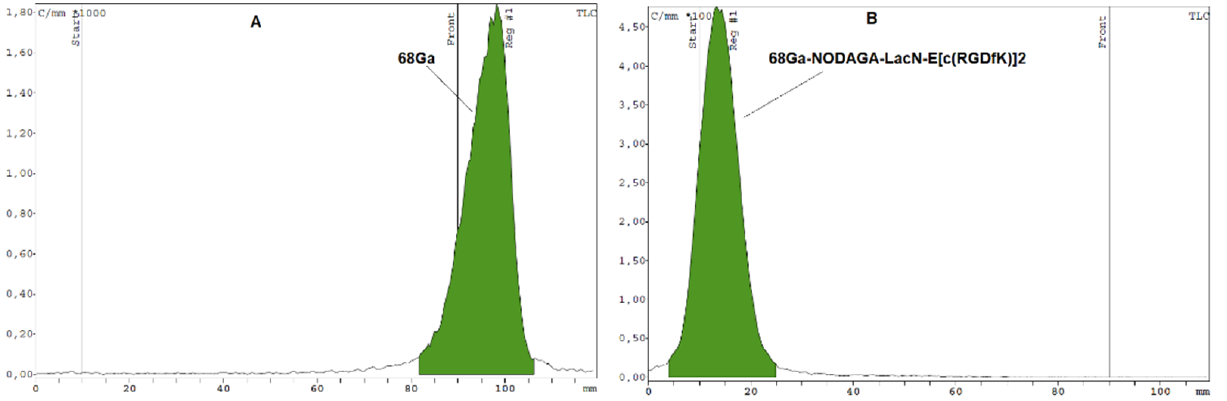
Figure 2. Radio-TLC chromatogram of free 68 Ga 3+ ( A ) and radio-TLC chromatogram of the purified radiotracer ( B ) using iTLC paper and 0.5 M citrate buffer (pH 5.5) as an eluent.